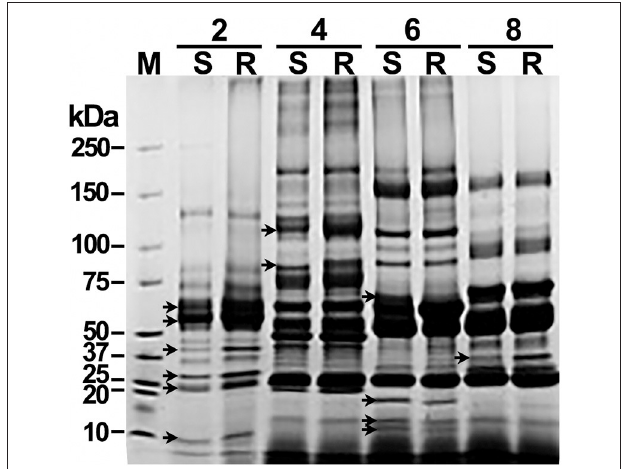
FIGURE 1 | Offgel separation of serum proteins by pI and matching by molecular weight reveal significant differences between susceptible and resistant cattle. Samples of pooled sera depleted of high-abundance proteins were fractionated by pH by offgel electrophoresis. Single offgel fractions were separated on a 4–20% gradient SDS-PAGE, loaded with 10 µ g of protein per well by pairing samples from susceptible (S) and resistant (R) cattle. Proteins were Coomasie blue stained. A paired comparative densitometry analysis was carried out to seek differences of ≥ 2 times among pairs of protein bands. A Coomassie blue-stained SDS-PAGE of serum fractions 2, 4, 6, and 8 representatives of that with significant differences in protein bands (arrows) is shown. M, protein molecular weight